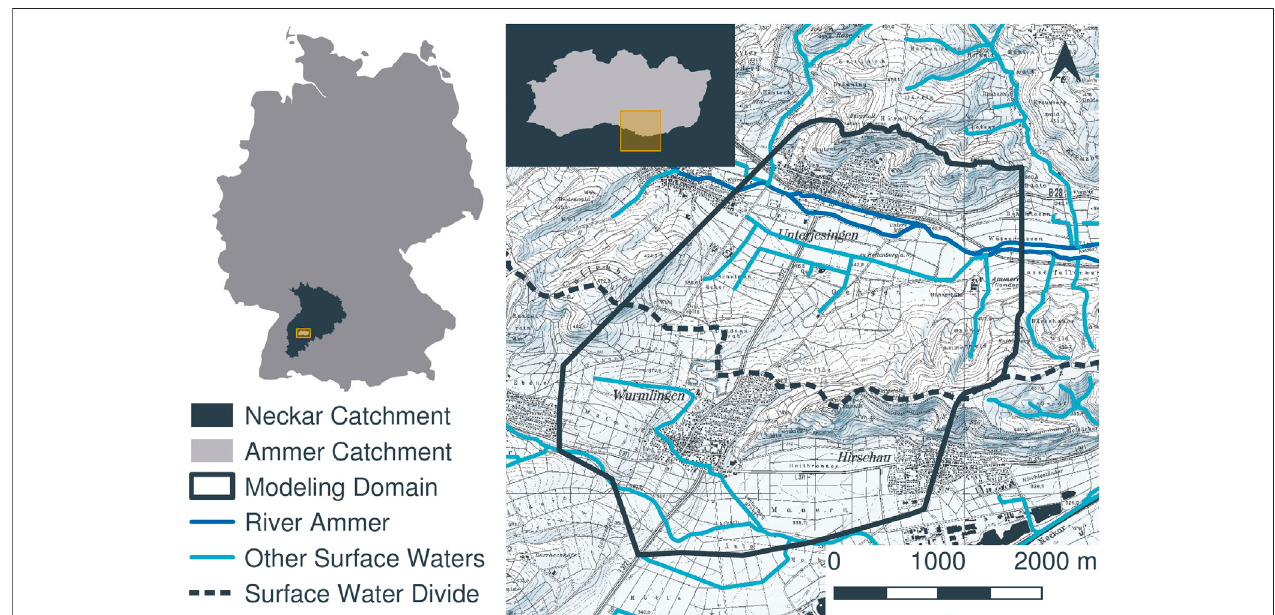
FIGURE 3 | Two-dimensional overview of the model domain and its location in